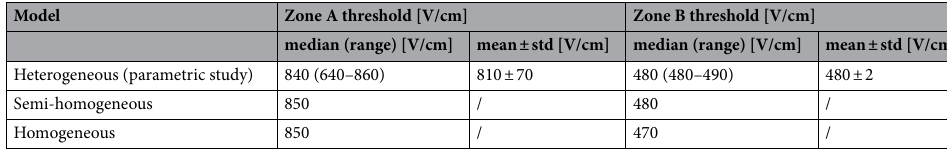
Table 2. Electric field thresholds for Zones A and B determined with models with different level of geometric detail. Only one section of the model, containing one active electrode pair, was computed due to computational